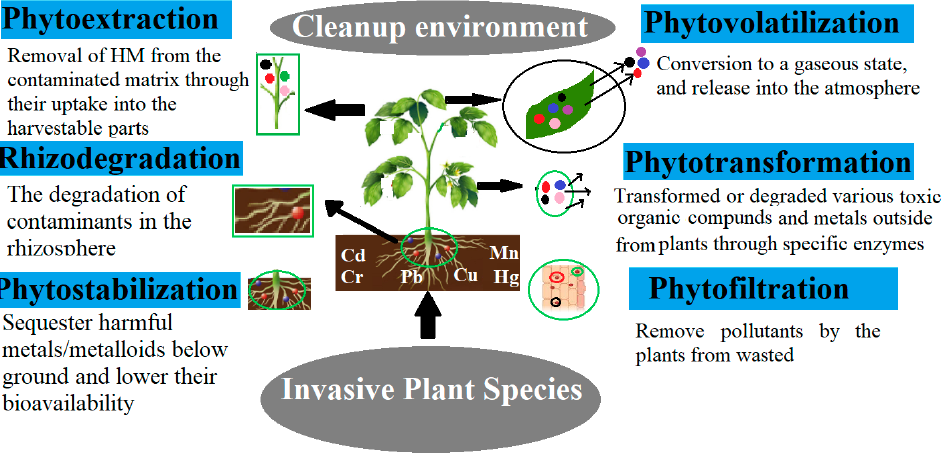
Figure 2. IPS can clean up the HMs through phytoremediation Strategies. Different techniques con- trol or minimize the toxicity of HMs in